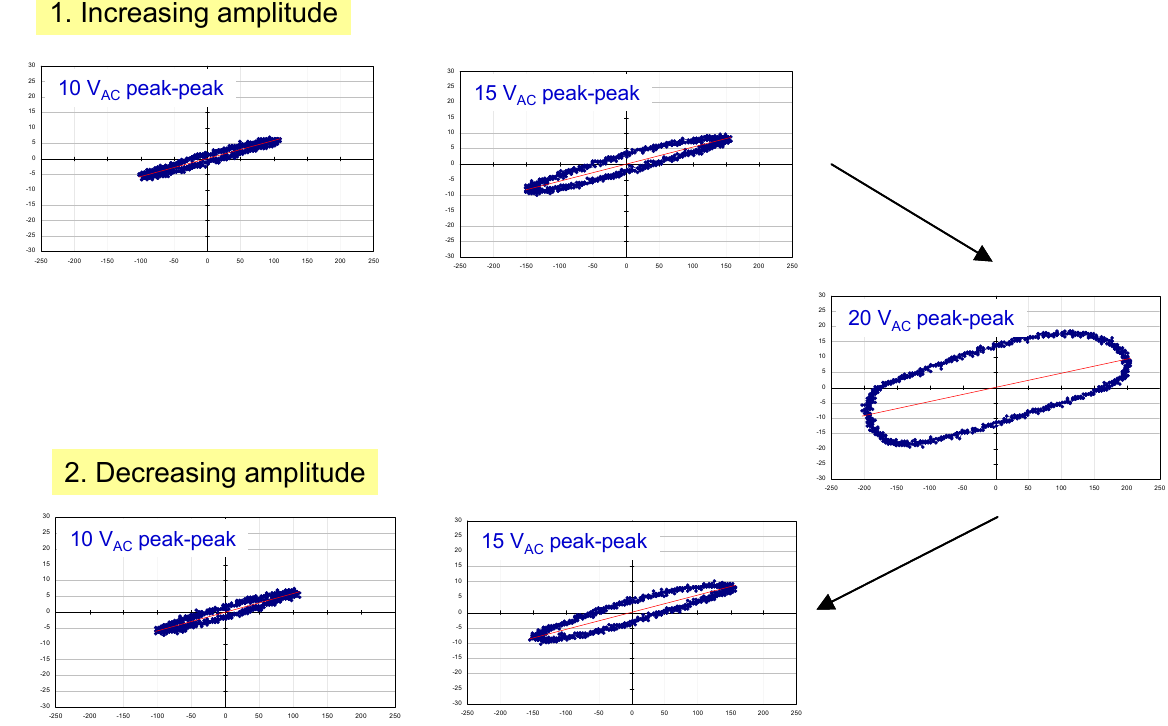
Figure 3. Polarization vs . applied voltage hysteresis loops measured at 20 Hz for a capacitor with a Pt bottom electrode, a BCZTO dielectric deposited at 700 °C, 10 mtorr pressure, a sputter gas mixture of 10% oxygen/ 90% argon, and a Ni top electrode.